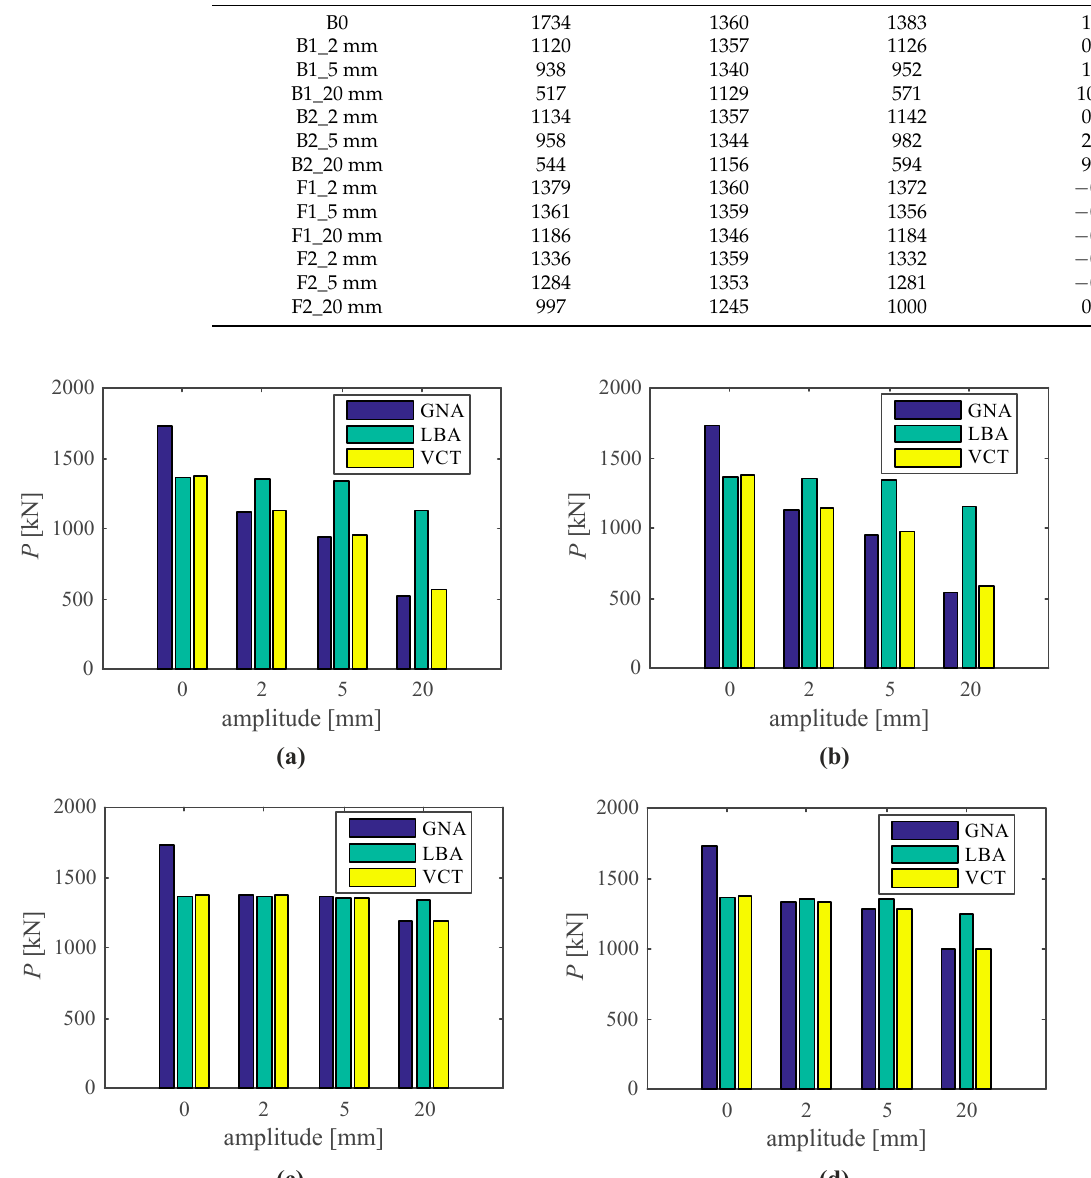
Figure 10. GNA, LBA and VCT loads versus imperfection amplitude of the silo segment with initial geometrical imperfections as modes: ( a ) first buckling (B1), ( b ) second buckling (B2), ( c ) first vibration (F1), ( d ) second vibration (F2).